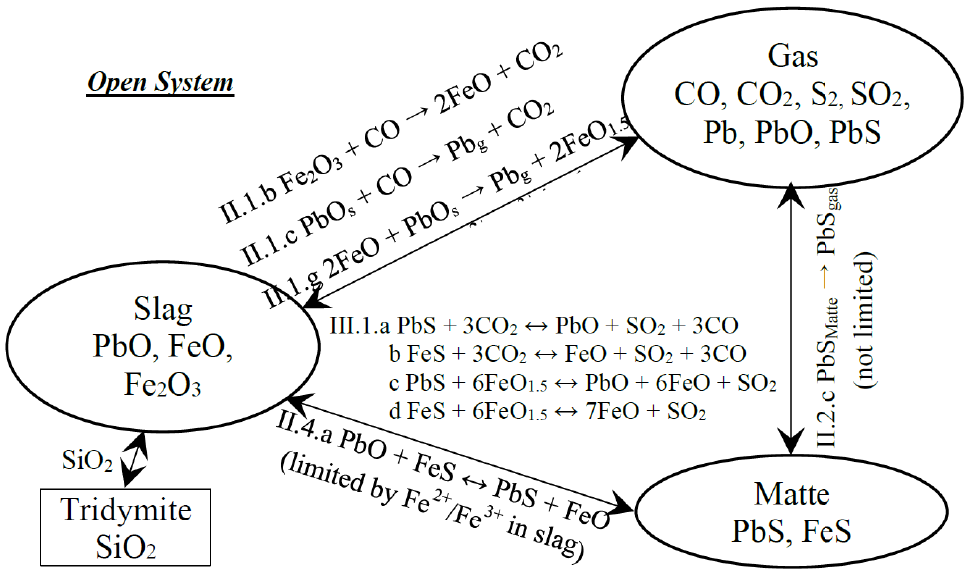
Figure 7. Interphase mass transfer diagram of the key mass transfer elements and reactions expected to be important in the open system.